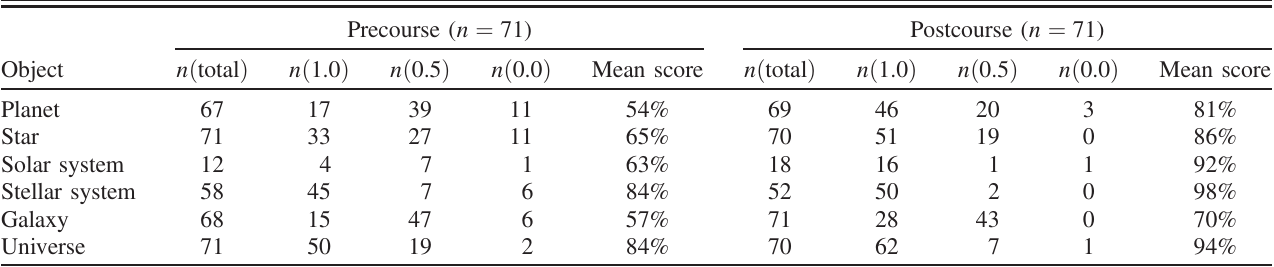
TABLE VII. Scores on the explaining task, for the sample of matched students ( n ¼ 71 ) who answered the question both pre- and postcourse.